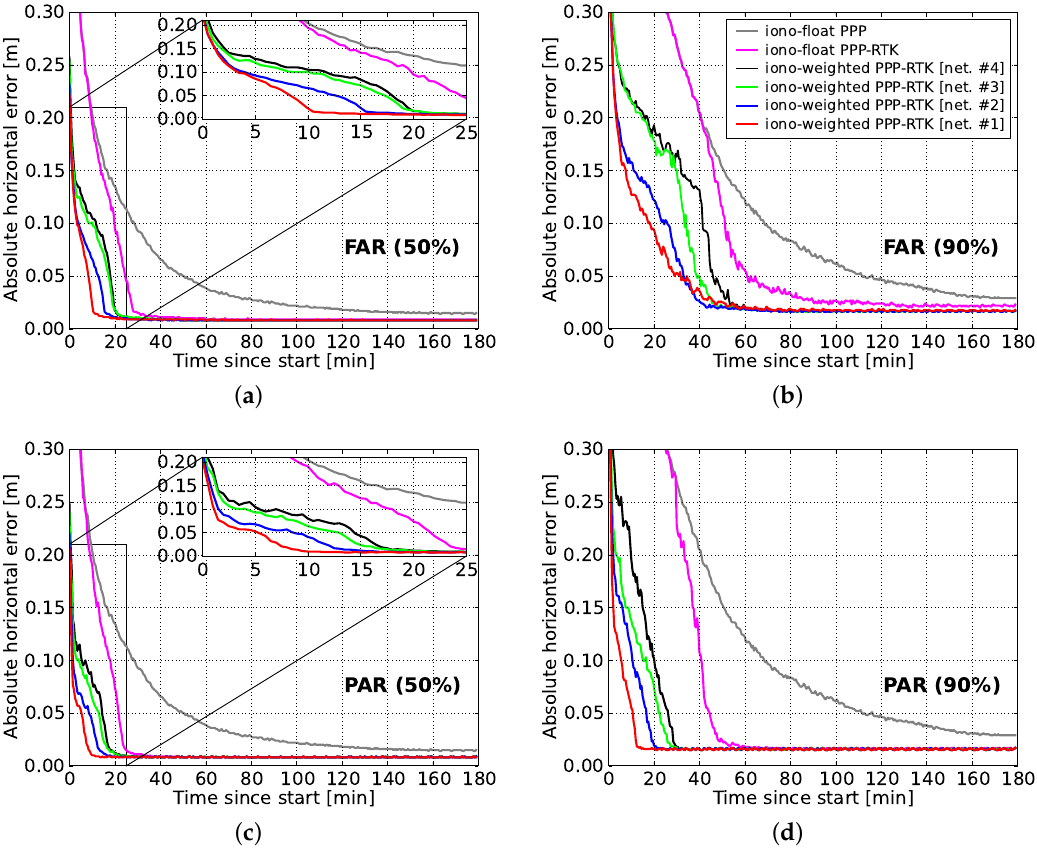
Figure 8. Convergence behavior of the horizontal radial positioning errors for ( a ) 50% of the FAR-based solutions, ( b ) 90% of the FAR-based solutions, ( c ) 50% of the PAR-based solutions, and ( d ) 90% of the PAR-based solutions of all user stations as a function of time since the processing start. The processing window has been re-initialized every 1 min within the selected day for all available solutions and